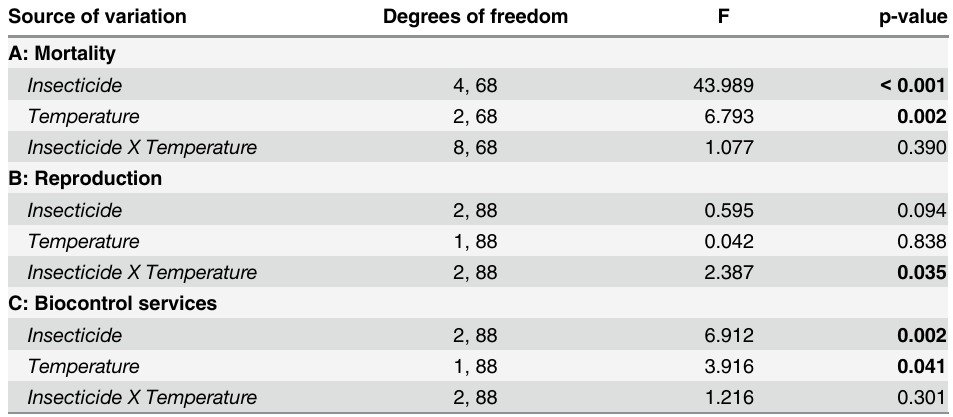
Table 2. Statistics from the multifactorial ANOVA used to analyze (A) the percentages of parasitoids found dead after 3 days of exposure to insecticides (mortality), (B) the total numbers of eggs laid (reproduction) and (C) the numbers of host larvae killed (biocontrol) by each Bracon nigricans female during the three days following the insecticide exposure. P values indicates in bold are those significant at < 0.05